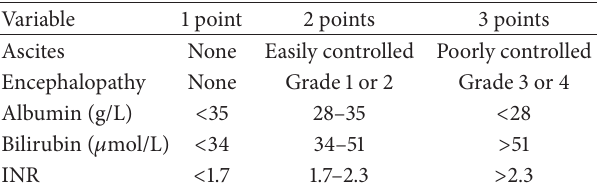
Table 2: CanWAIT allocation